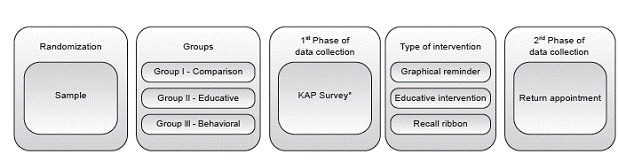
Data collection flowchart